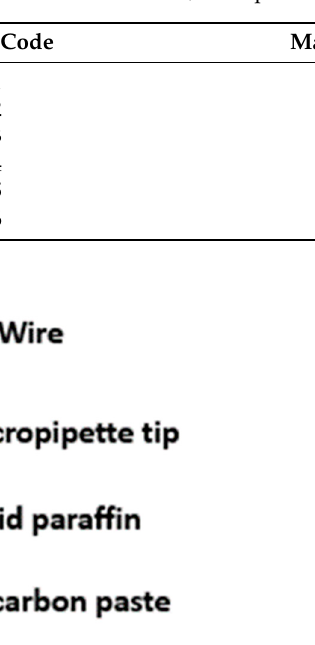
Figure 2. The construction of the IZ–carbon paste sensor [19] (Source: please see reference 19).